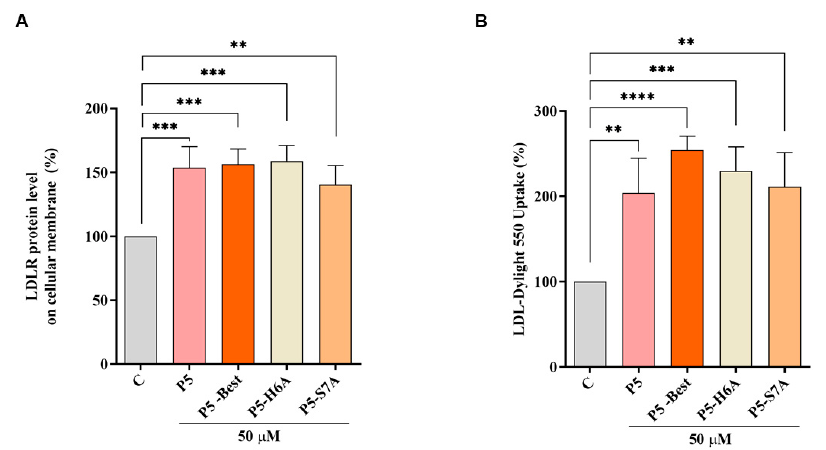
Figure 6. Modulation of the LDLR pathway in HepG2 cells. ( A ) The effect on the LDLR localized on the surface of HepG2 cells after the treatment of HepG2 cells with P5 and P5 analogs, respectively. ( B ) Enhancement of the functional ability of HepG2 cells to uptake LDL from the extracellular environment. Data points represent the average ± SD of four independent experiments performed in duplicate. C vs. P5, and P5 analog samples were analyzed using one-way ANOVA, followed by by Tukey’s test; (**) p < 0.01, (***) p < 0.001, and (****) p < 0.0001. C: control sample.